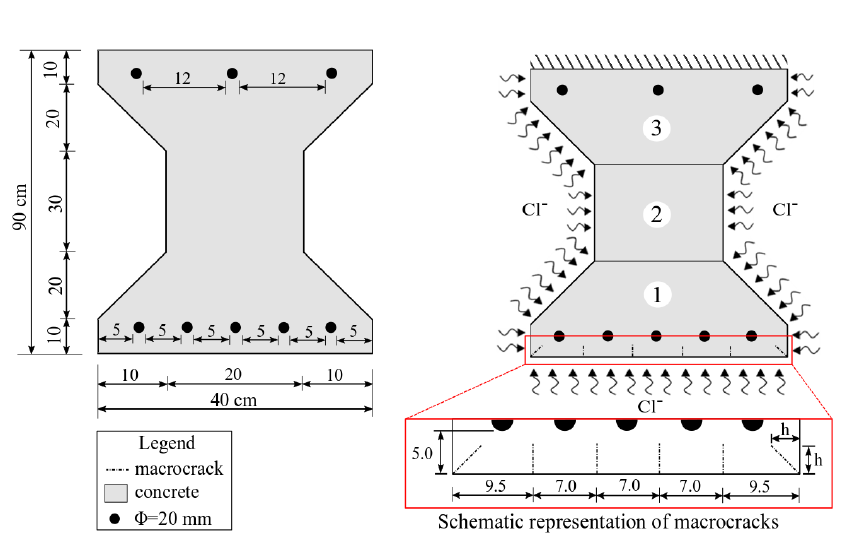
Figure 6. Cross-section geometry (measured in cm) and boundary